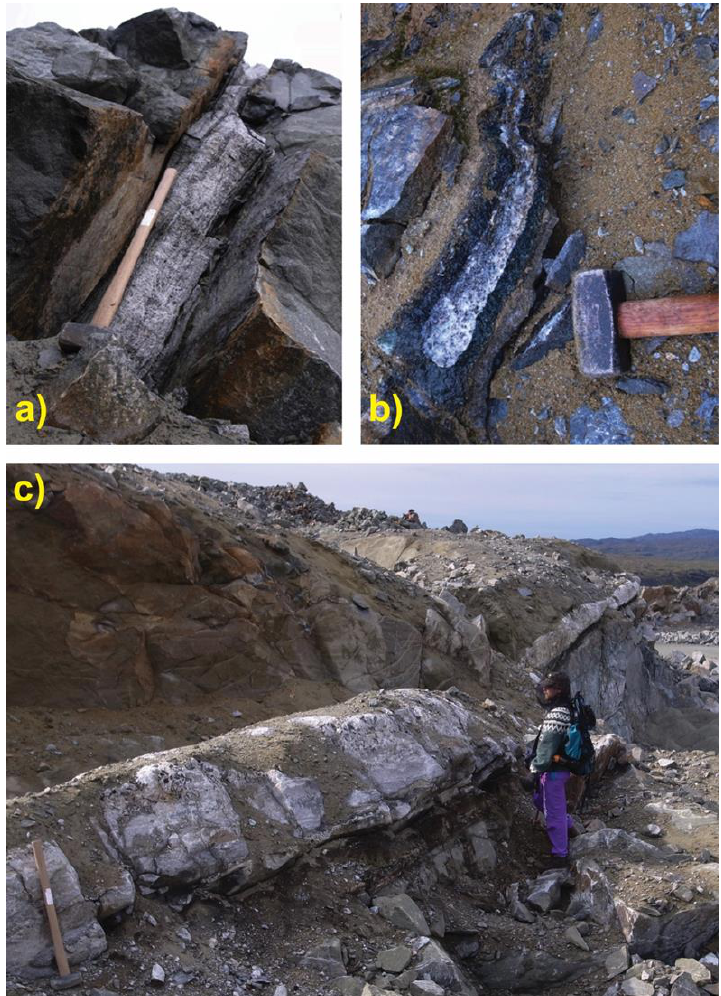
Figure 3. Field photos from the Seqi Olivine Mine showing examples of felsic intrusive sheets in dunite. ( a ) 40 cm thick intrusive tonalitic sheet (sample 186451), which was dated at 2963 ± 6 Ma [5]. Note the dark contact zone, which is dominated by talc and mica. ( b ) 20 cm felsic intrusive vein in dunite with obvious metasomatic reaction halo, which almost completely consumes the granitoid rock. ( c ) Large (1.5 m) NE–SW trending trondhjemitic pegmatite sheet (sample 186453) in the central part of the Seqi Olivine Mine